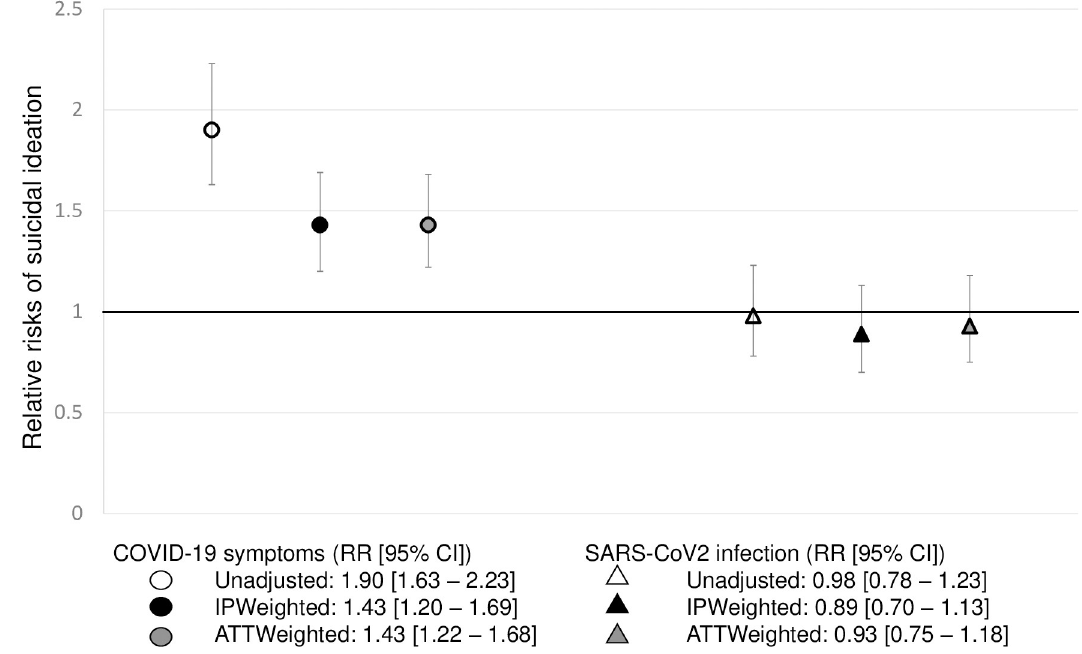
Fig 3. Relative risk of suicidal ideation following self-reported COVID-19-like symptoms or SARS-CoV-2 infection in the EpiCov cohort.